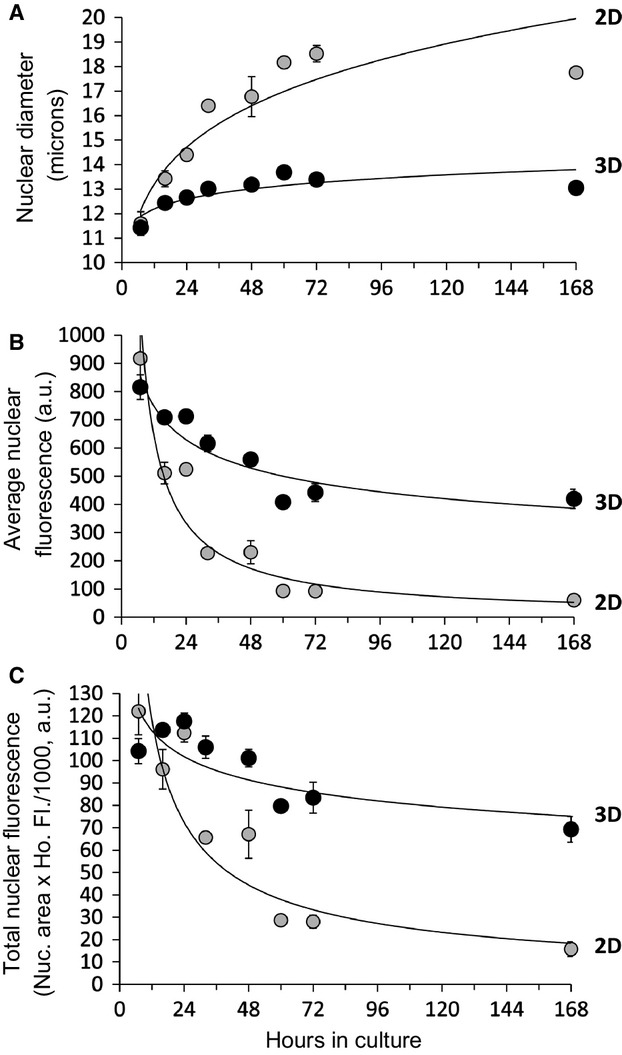
Nuclear diameter increases and accumulation of Hoechst nuclear stain decreases for primary hepatocytes under 2D culture. Hepatocytes of Fig. 1 were analyzed for their average nuclear diameter (A) and nuclear fluorescence intensity from Hoechst dye (B). The total nuclear fluorescence (C) (i.e., the integrated Hoechst fluorescent intensity) decreased over time, indicating that Hoechst dye was being excluded from nuclei at later time points. Lines indicate curve fit of the data using the power function (y = axb). For simplicity, data from the control (i.e., lacking fluorescent anion) are shown; results from the other experiments were similar. Error bars are standard error of the mean of three experiments.